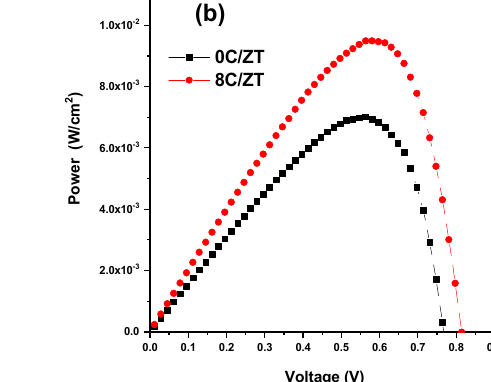
Figure 17. Characteristic curves of the solar cells’ ( a ) current density versus voltage and ( b ) power versus voltage for ITO/CdS/i-ZnTe /p-CdTe and ITO/CdS/i-ZnTe/ZnTe:Cu/p-CdTe.